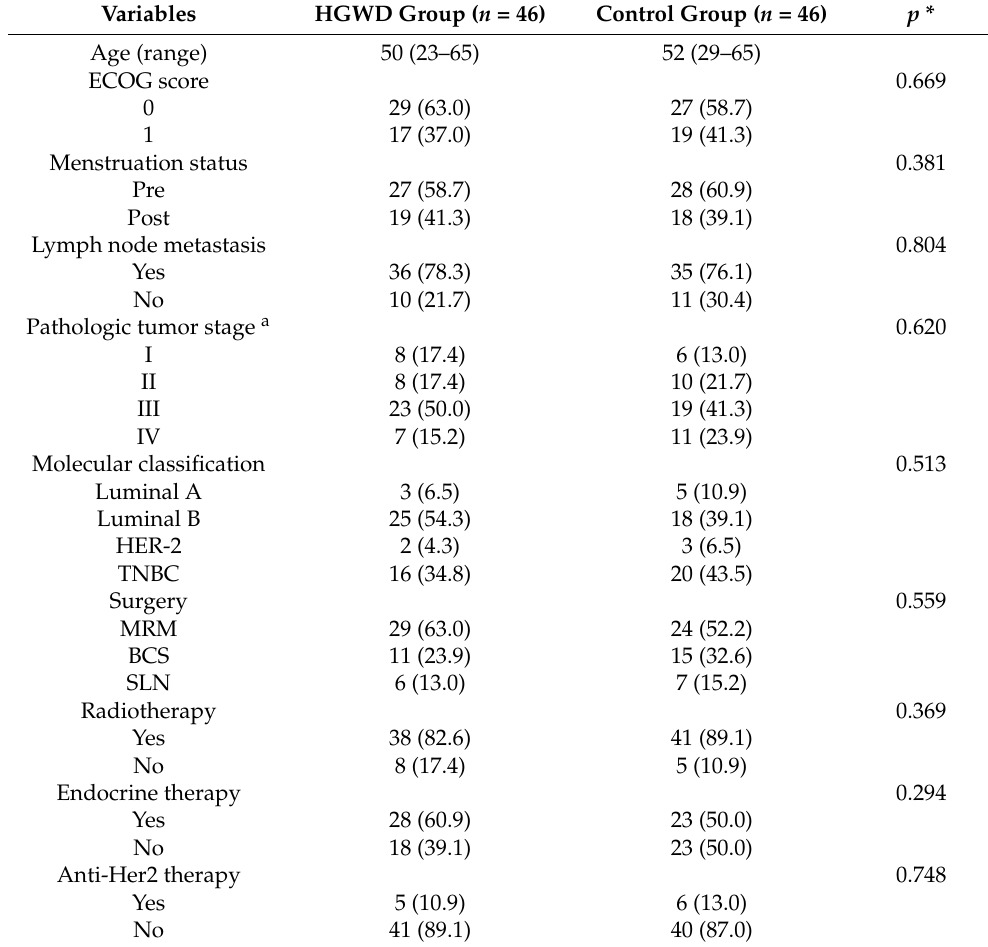
Table 1. Baseline characteristics of eligible patients with breast